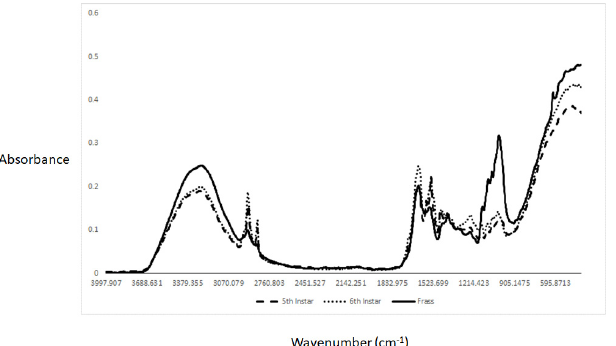
Figure 1. Average spectra (both waste streams combined) of instars (5th and 6th) and frass samples analyzed using attenuated total reflectance mid-infrared spectroscopy after baseline correction.